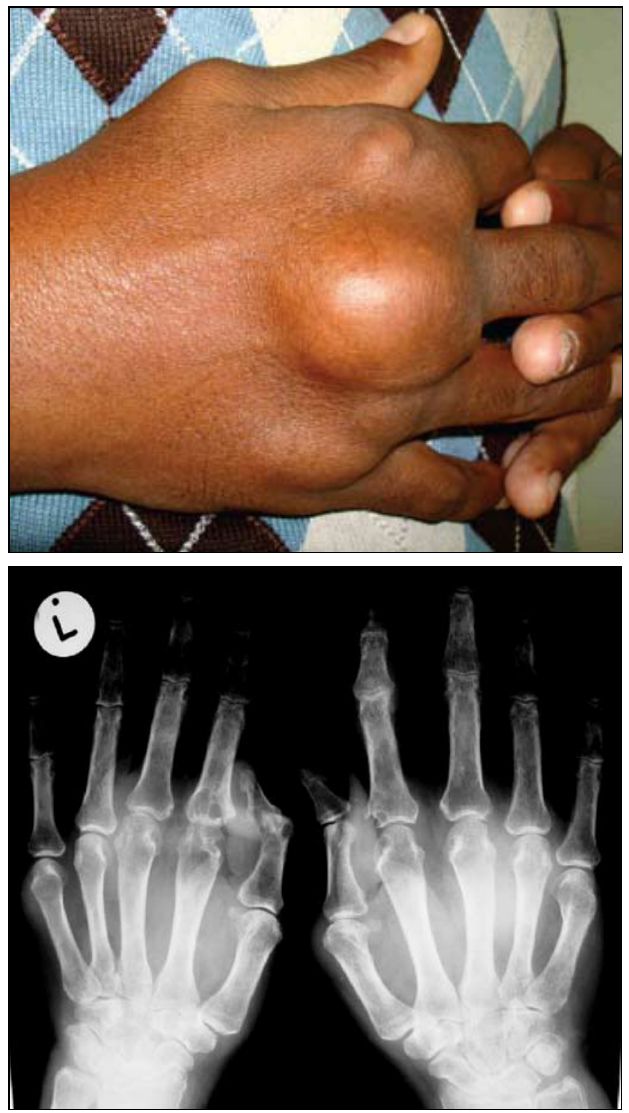
Fig. 3. Photograph of the right hand and anteroposterior radiograph of both hands show large soft-tissue tophi around the MTP joints and typical involvement of the MTP joints by gout.